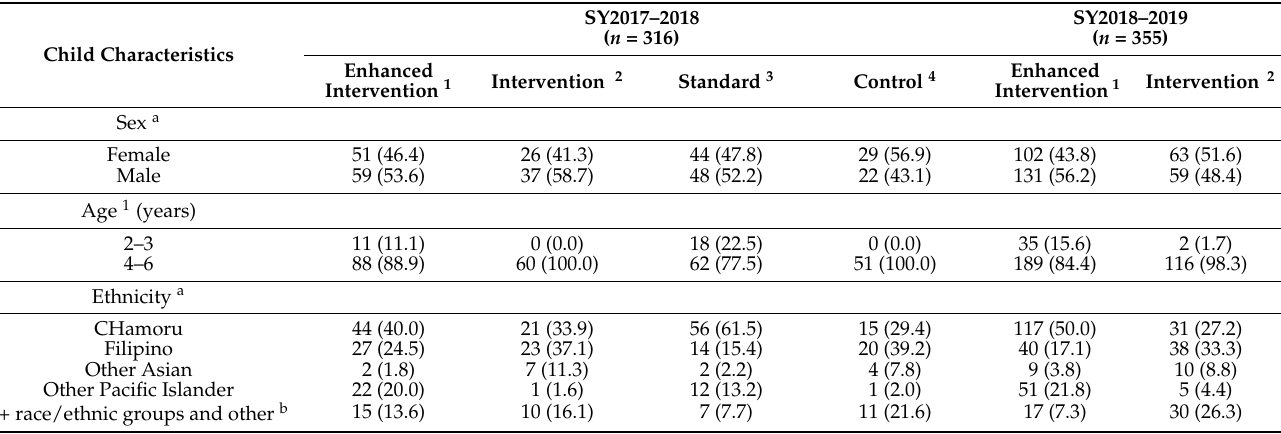
Table 1. Characteristics of child study participants in Guam preschool programs that received FFMM, IMIL, both, or none during two school years (i.e., SY2017–2018 and